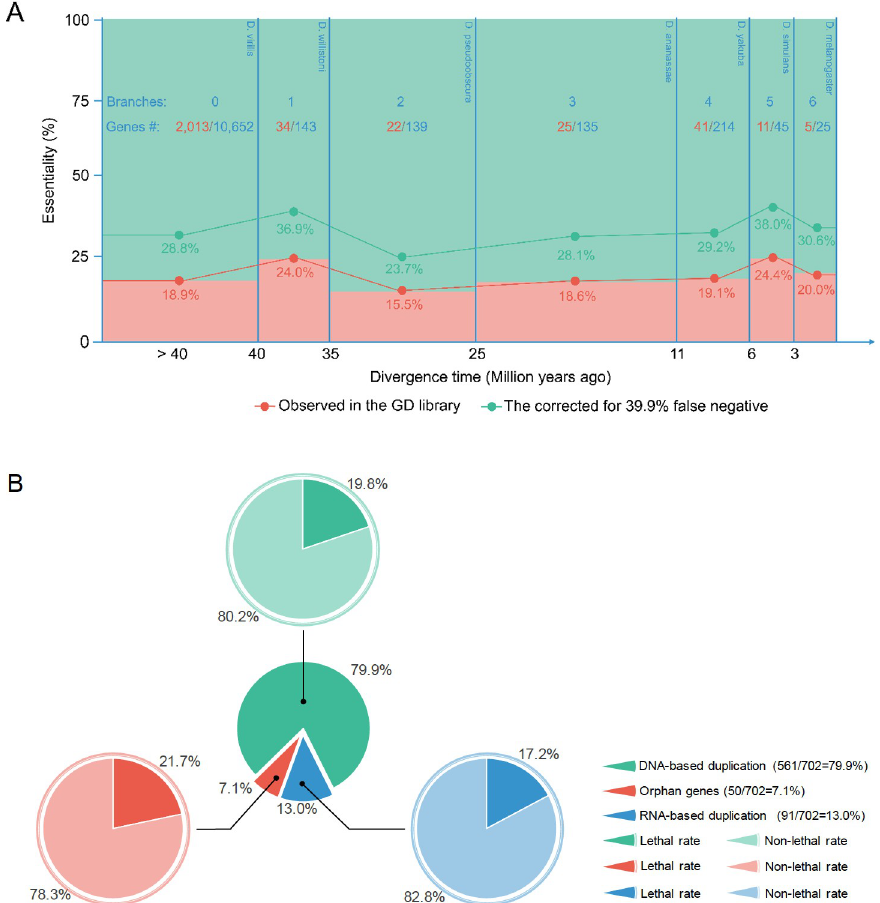
Fig 5. Lethality proportion of 702 Drosophila -specific genes. A. Lethality proportion of 702 Drosophila -specific genes in 6 ancestral stages of extant D . melanogaster , compared to the lethality proportion of 10,652 genes older than 40 Mya. No stages show an essentiality proportion significantly different from that of old genes (0.189). B. Lethality proportion of 702 Drosophila-specific genes based on three origin mechanism catalogs. No catalog shows a lethality proportion significantly different from that of old genes